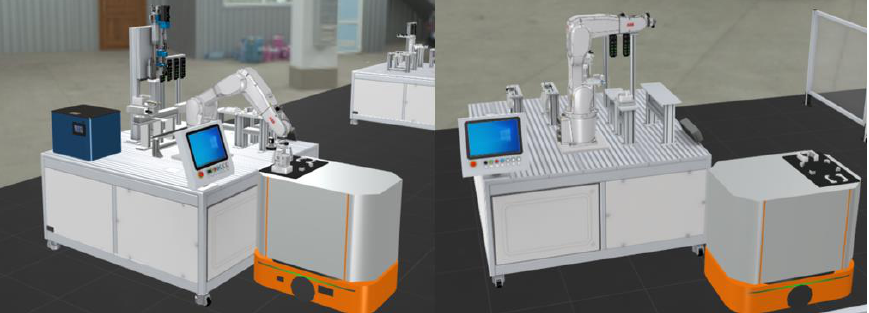
Figure 3. Stereoscopic virtual action implementation